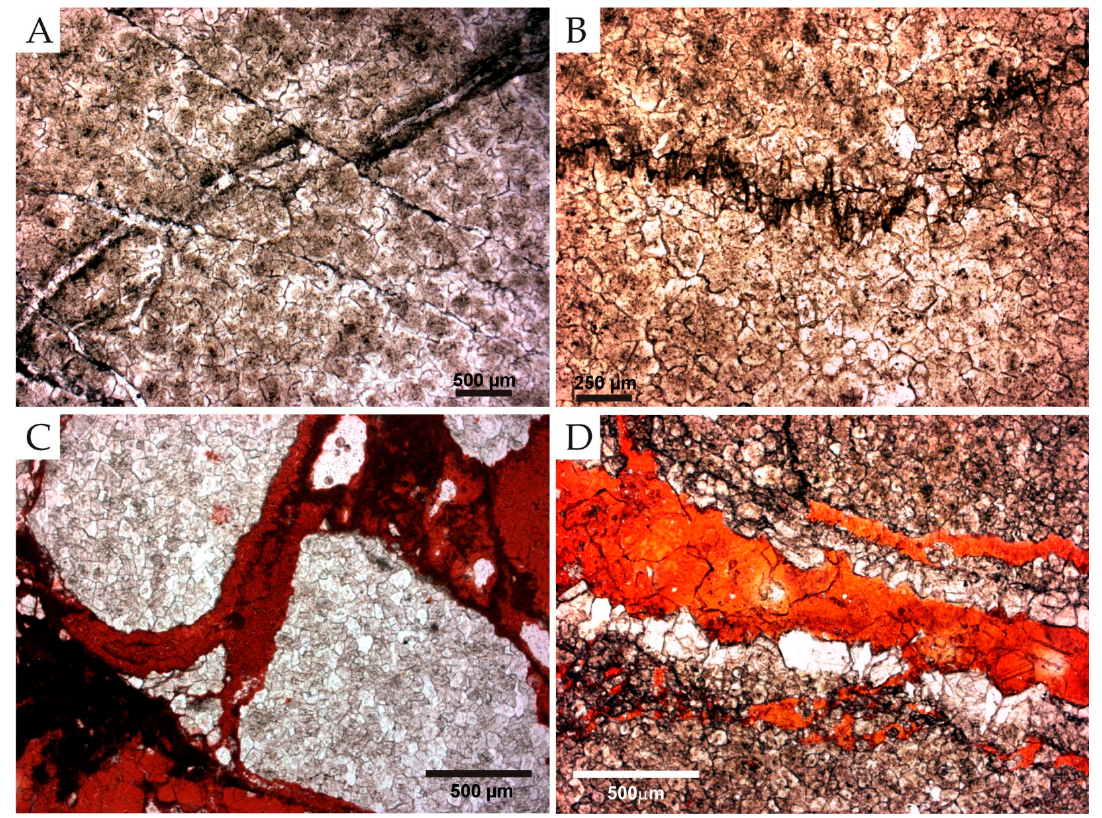
Figure 5. Discontinuities and cements in Marrón Emperador breccia facies. ( A ) Network of fissures and veinlets in mesocrystalline hypidiotopic dolosparite (Y section). ( B ) Stylolite in mesocrystalline hypidiotopic dolosparite (Y section). ( C ) Equant calcite cements occluding interparticle and fracture porosity in dolosparite (SPS section). ( D ) Dolomite and calcite cements filling fracture porosity (Y section). Table 3. Mineralogical composition of brecciated microfacies in the study area.